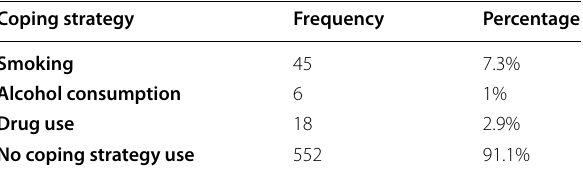
Table 5 Frequency and percentage of coping strategies during